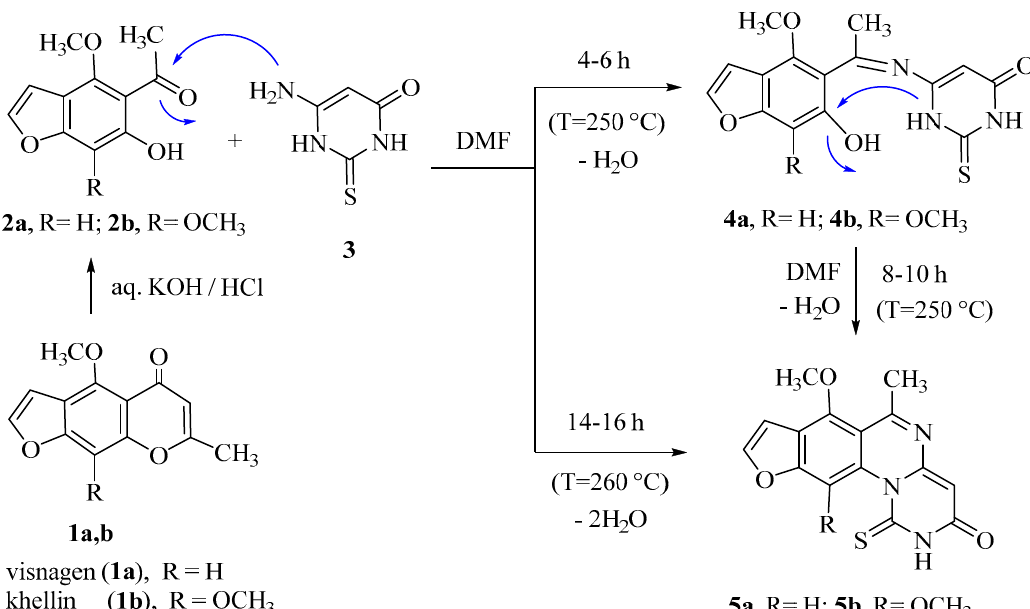
Scheme 1. Synthesis of furopyrimido quinazolinones from visnagenone and khellinone